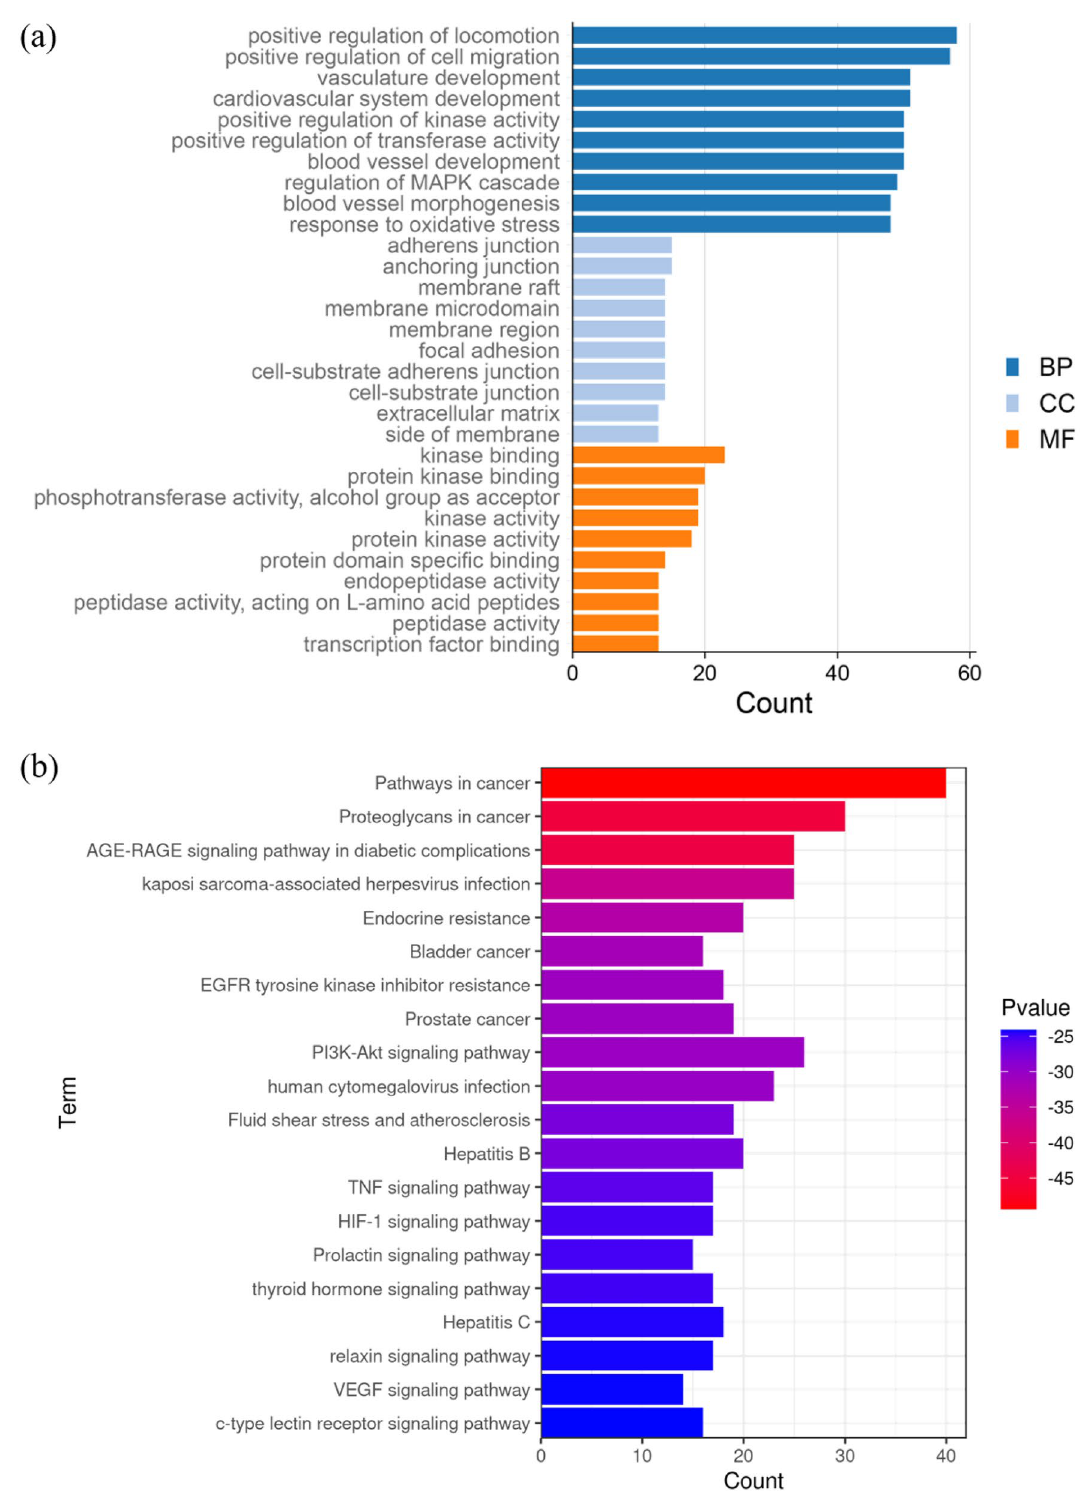
Figure 8. ( a ) GO enrichment results ( b ) KEGG pathway enrichment results (this figure was drawn by the Bioinformatics Data analysis and Visualization online platform (http:// www. bioin forma tics. com.